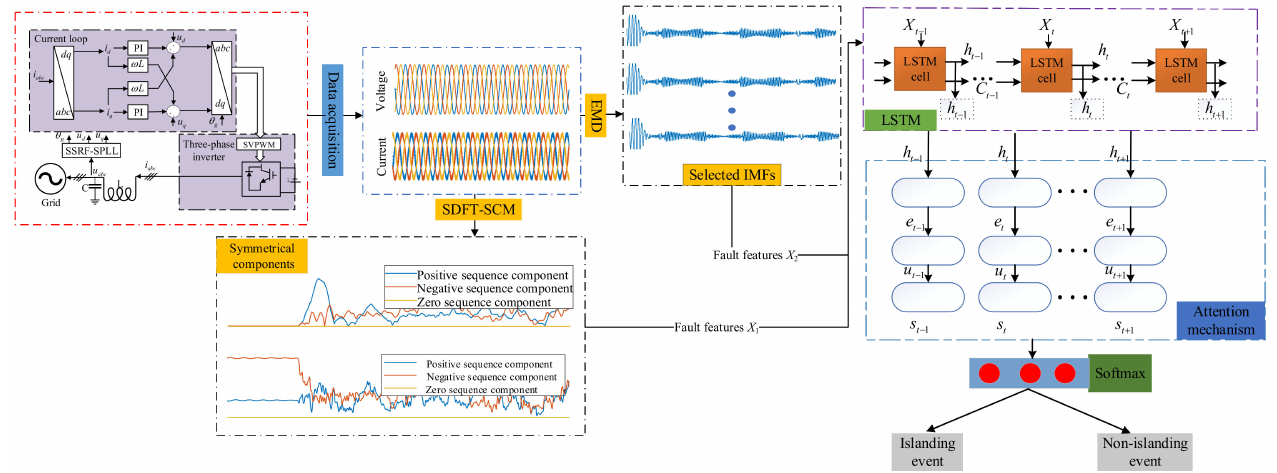
Figure 13. Schematic diagram of the intelligent islanding detection